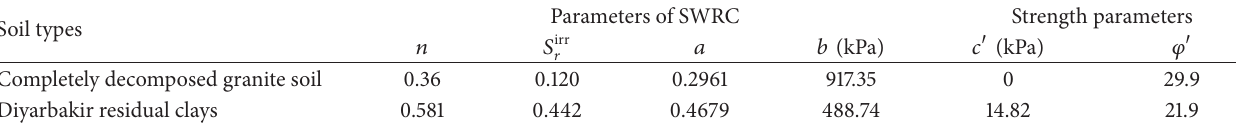
Figure 5: Comparison of tested data with the predictive curve of suction strength and shear strength (measured data from Hossain and Yin [20]). Table 1: Parameters of SWRC of unsaturated soil and shear strength of saturated soil for predicting suction strength of unsaturated soils that underwent single drying hydraulic path.